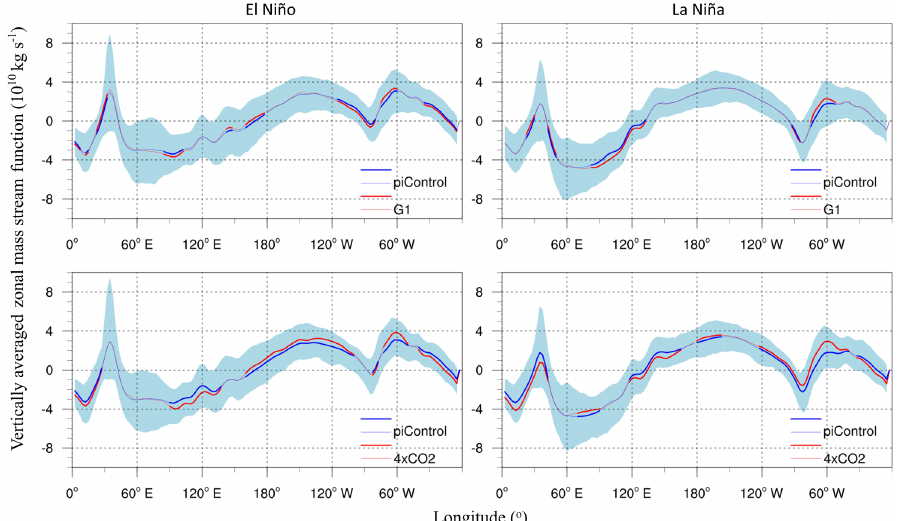
Figure 9. The vertically averaged zonal mass stream function under ENSO. For El Niño or La Niña conditions, the blue line in each panel represents the vertically averaged zonal mass stream function (10 10 kgs − 1 ) under piControl. The red line in the top row is G1 and the bottom row is abrupt4xCO2. The thick lines denote locations where circulation changes are significant at the 95% confidence level. The 16–84% range across the eight individual models is shown by light blue shading.